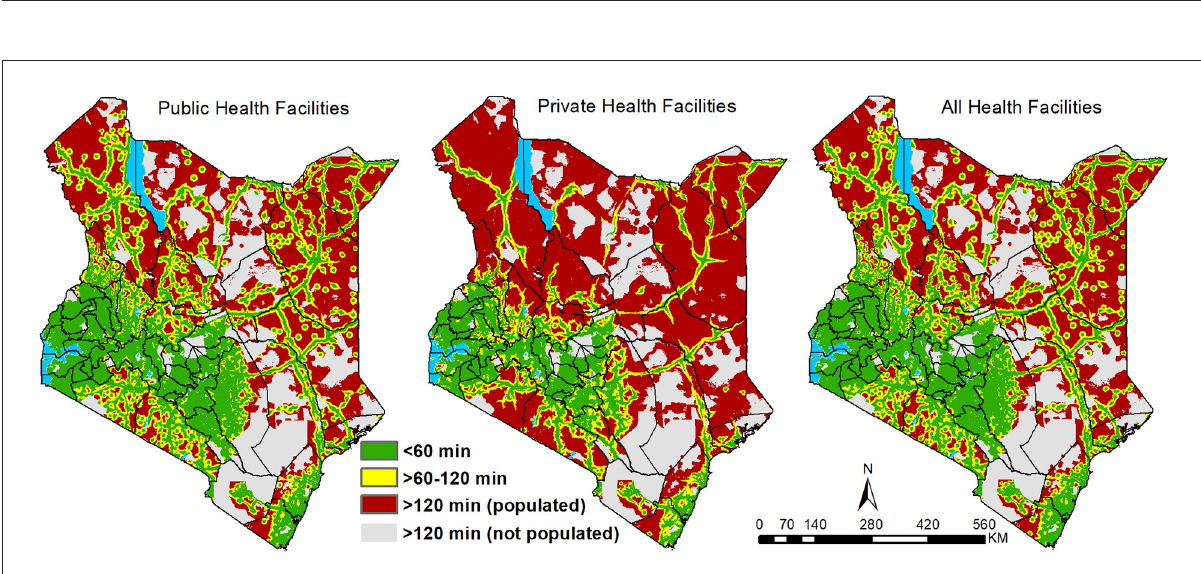
FIGURE2 Travel time to the nearest public, private and combined (public and private) health facilities binned based on travel time and population density in Kenya in